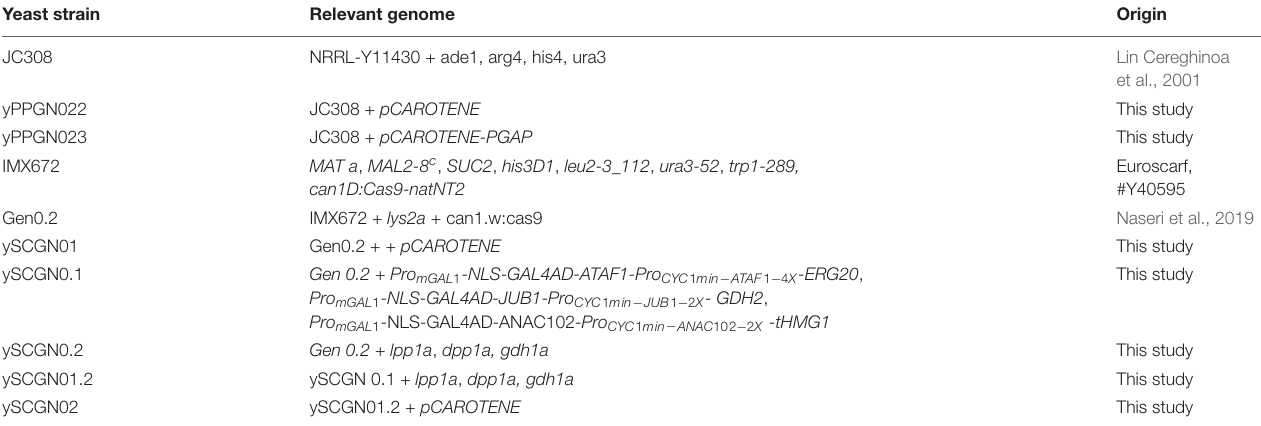
TABLE 2 | List of yeast strains used for β -carotene production in the present study. Yeast strain Relevant